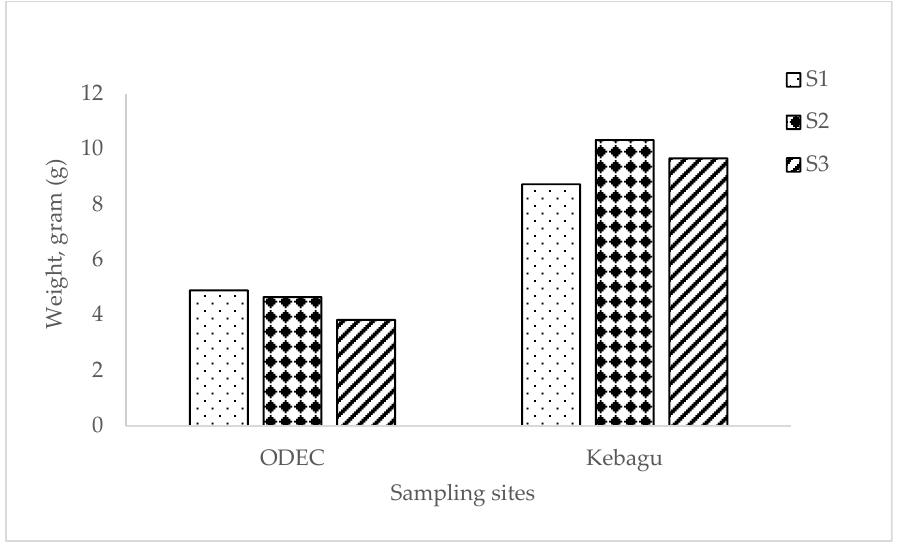
Figure 2. Weight of pooled plastic fragments collected from ODEC and Kebagu beaches.